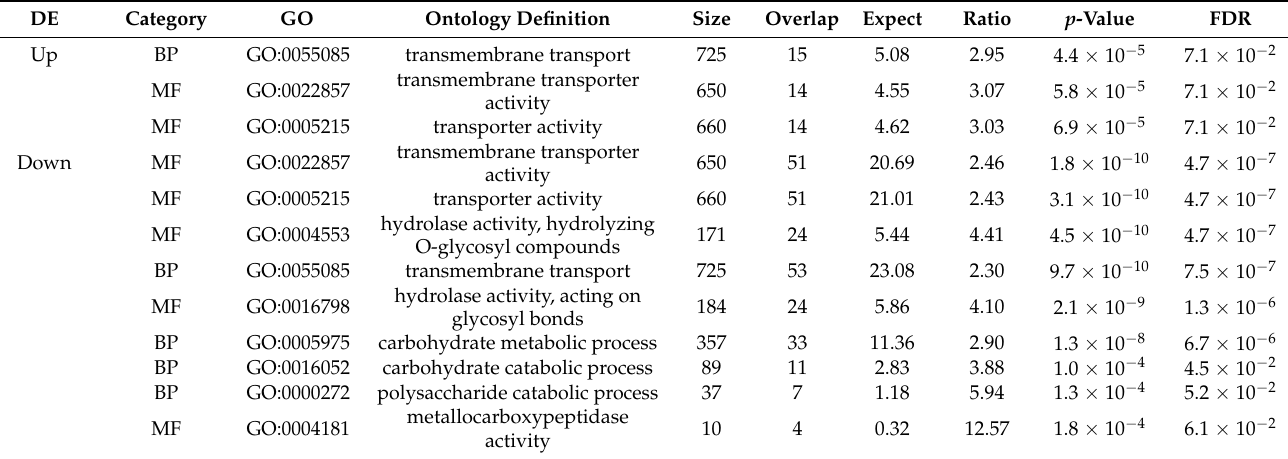
Table 1. Functional enrichment of differentially expressed genes (at 22 h time point) of Saitozyma podzolica DSM 27192 growing on glucose compared to xylose based on WebGestalt. BP and MF indicate biological process and molecular function, respectively. DE and FDR represent differential expression and false discovery rate, respectively. DE